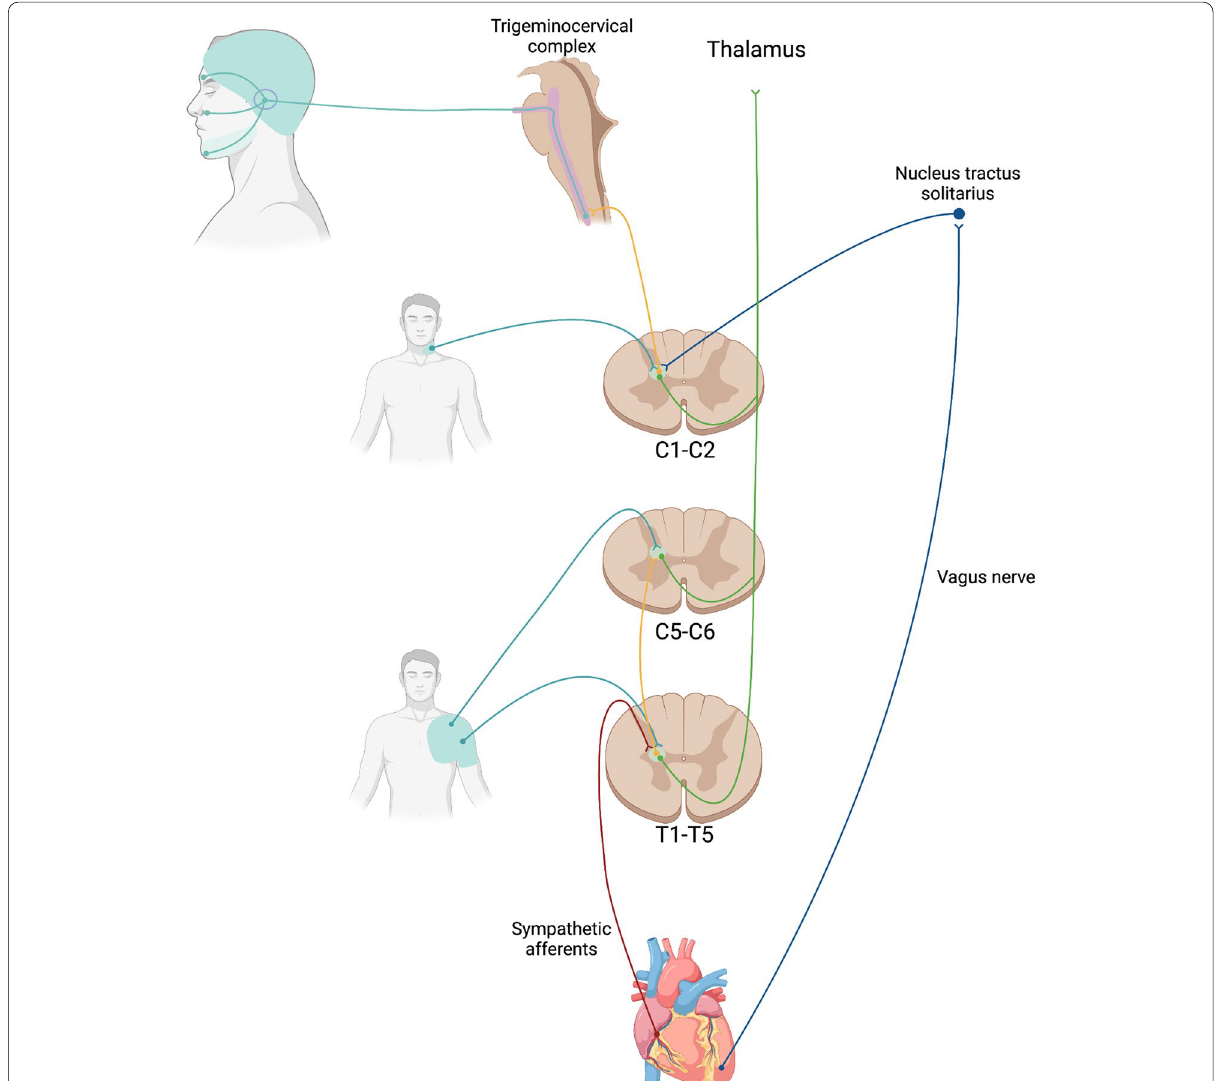
Fig. 3 Convergence theory of cardiac cephalalgia. Adapted from Foreman [58]. Adapted with permission from John Wiley and Sons. Figure legend: Sympathetic cardiac afferents converge in the spinothalamic tract (STT) neurons in the T1‑T5 and C5‑C6 segments with somatic fibers from the chest and upper arm respectively. Vagal afferents primarily terminate in the nucleus tractus solitarius and then project to the STT neurons located in C1‑C2 segments. These segments also receive nociceptive information from the neck and could also receive nociceptive input from the trigeminal region through the trigeminocervical complex. However, C1‑C2 segments do not receive significant stimuli from sympathetic